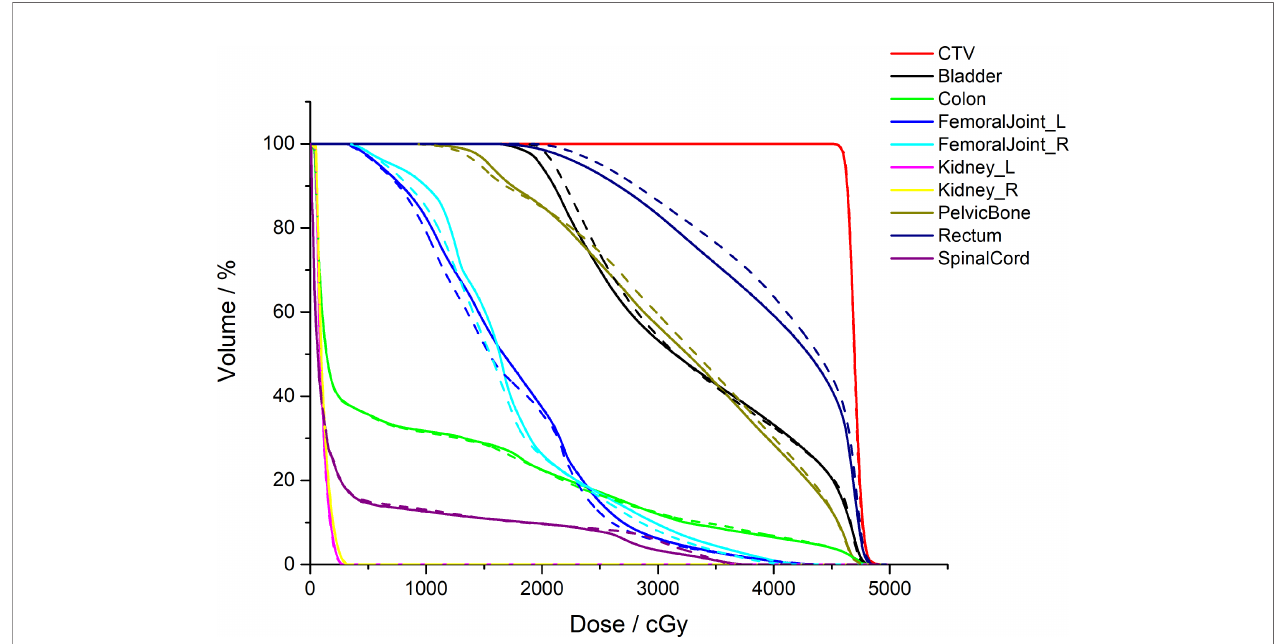
FIGURE 5 | Comparison of the clinical target volume (CTV) and normal tissue DVHs for one patient with cervical cancer. The dotted lines denote the treatment plans optimised by auto-segmented organ contours (AS-VMAT), whereas the solid lines denote the treatment plans optimised by manually segmented organ contours (MS-VMAT). AS-VMAT, automatic segmentations VMAT; MS-VMAT, manual segmentations VMAT.